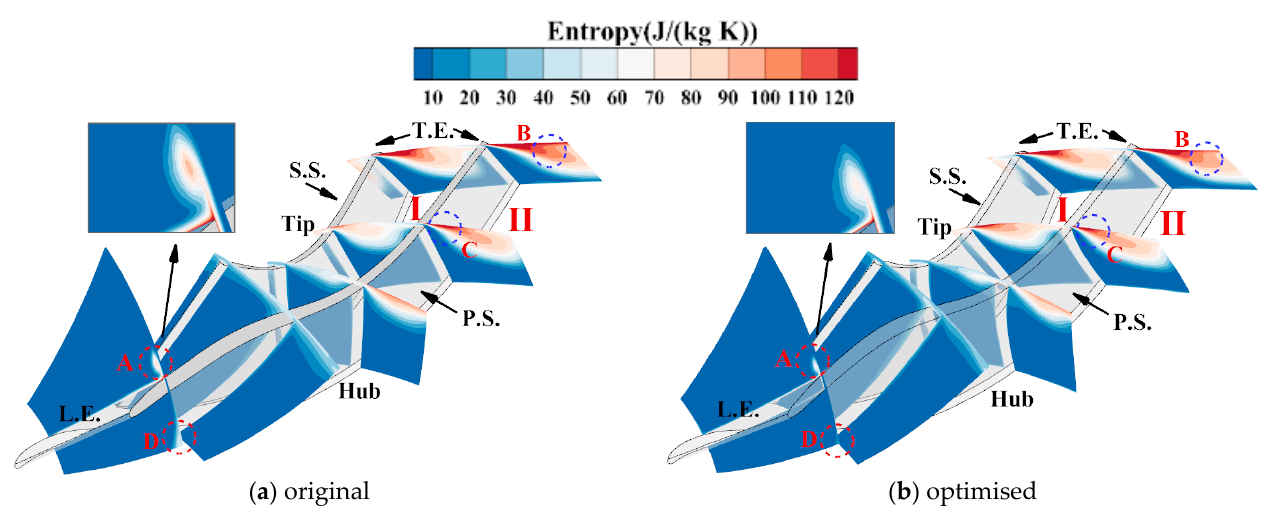
Figure 13. Entropy contour of the S3 cross ‐ section before and after optimisation (rated operating condition).